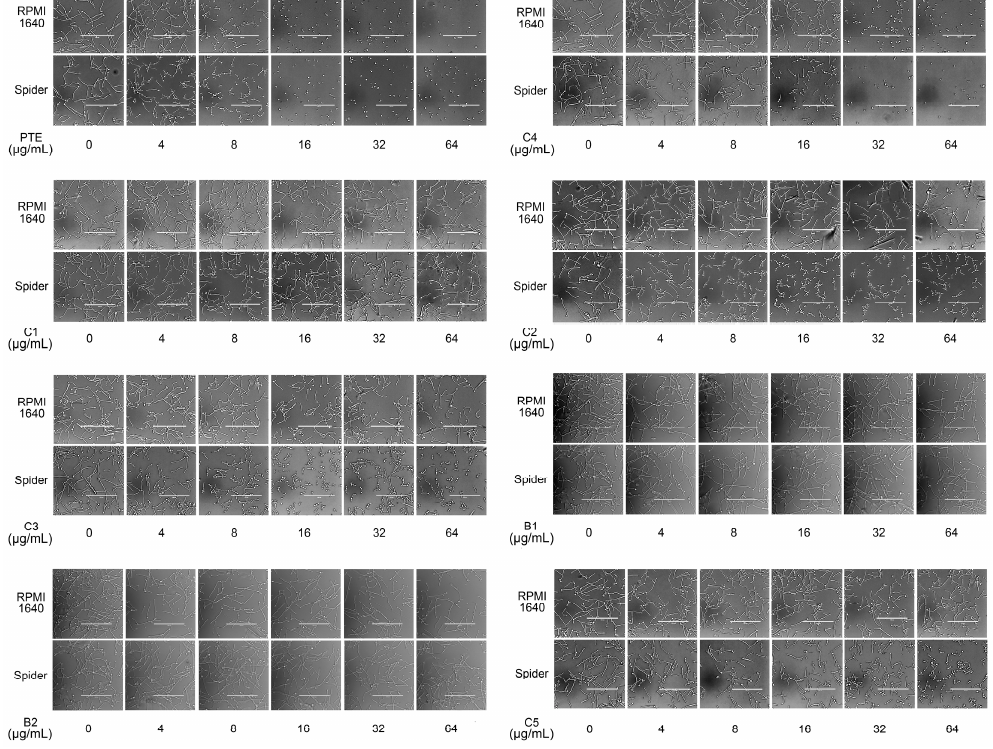
Figure 3. Effects of different concentrations of PTE and analogues C1–C5, B1, and B2 on hyphal formation. Exponentially-growing C. albicans SC5314 cells were transferred to hypha-inducing liquid media, including Spider and RPMI1640. The cellular morphology was photographed after incubation at 37 °C for 3 h. Scale bar = 100 μ m.